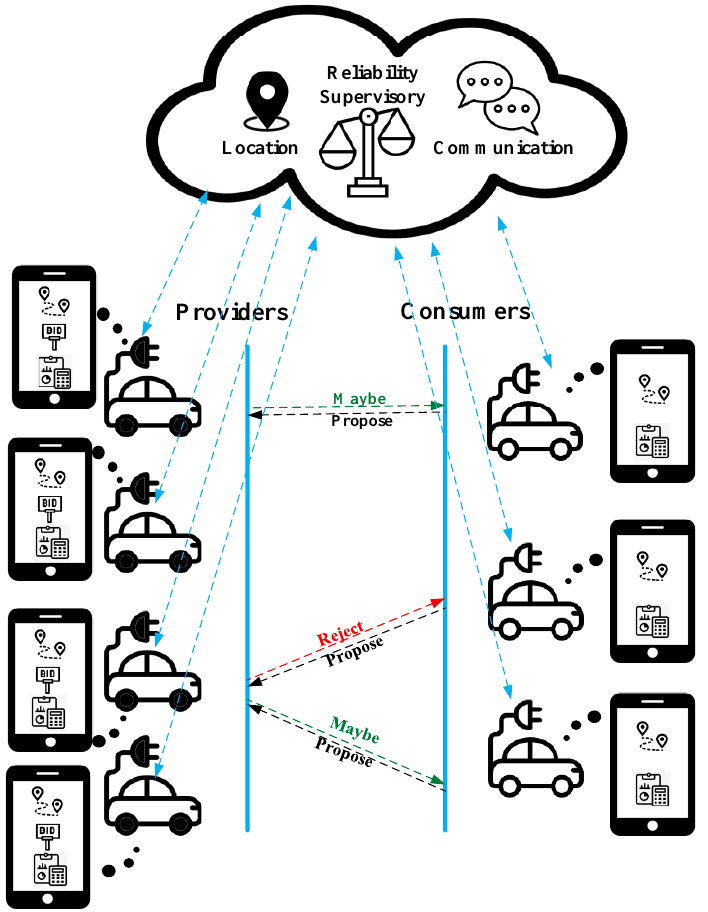
Figure 2. A schematic view of the proposed cloud-edge emergency energy trading framework.